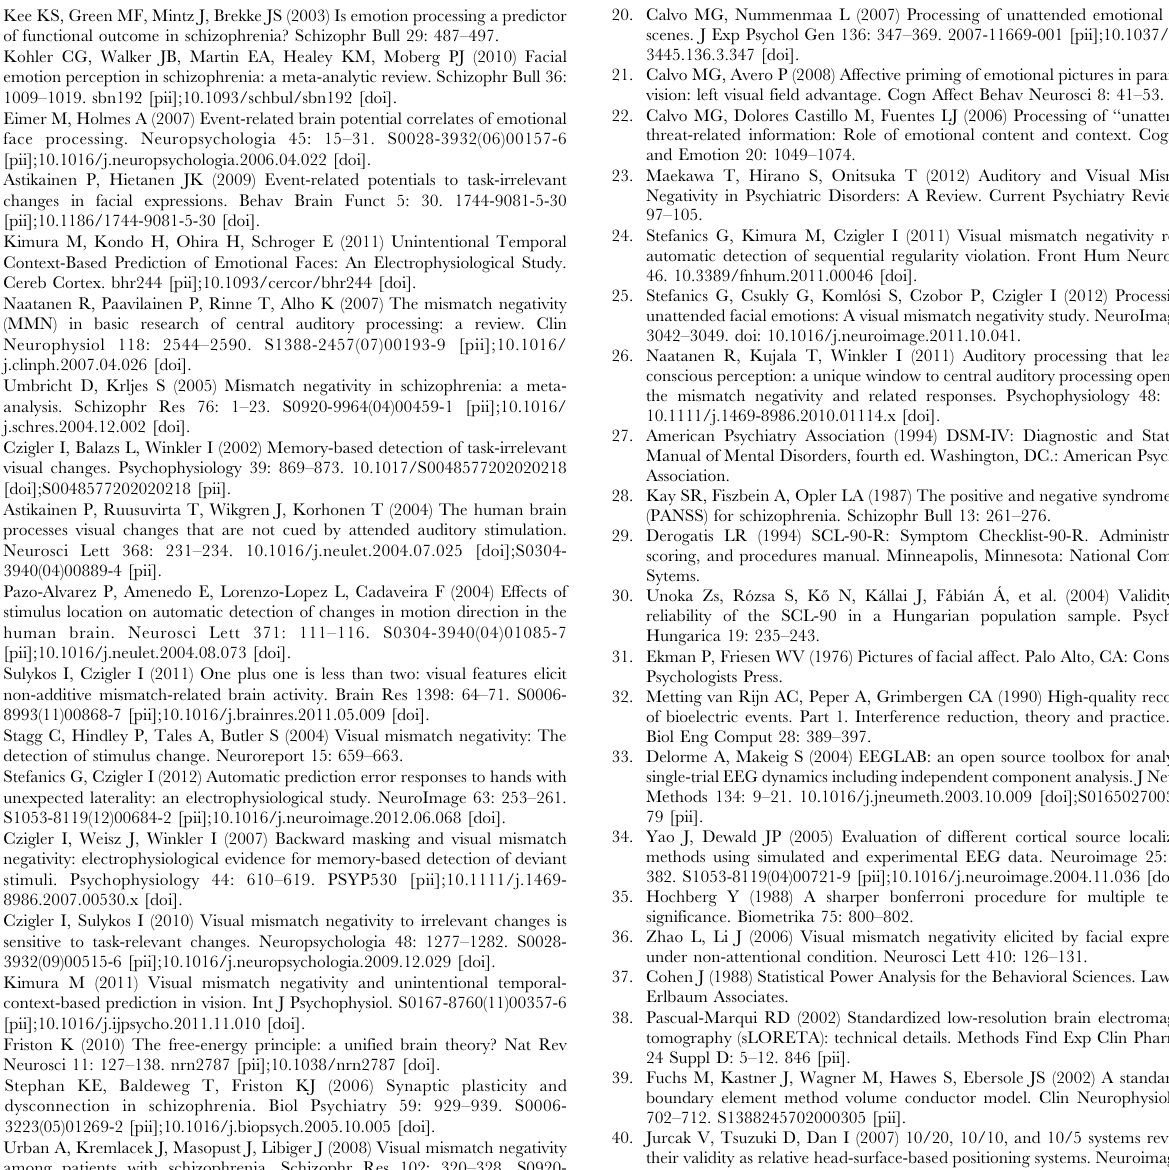
Figure S1 Event-related potentials and mismatch wave- forms by region (HC = Healthy Controls, SZ = Patients with Schizophrenia). Upper panel: ERPs for fearful faces; lower panel: ERPs for happy faces. Shaded intervals indicate time windows of amplitude measurements. Crosses mark time windows where deviant and standard waveforms differ significantly (i.e. significant mismatch